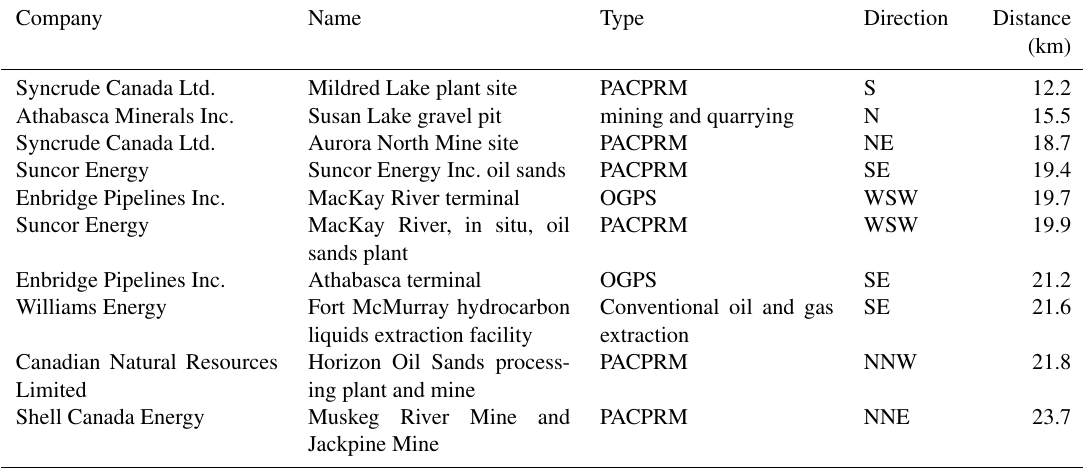
Table 1. Oil sands facilities located within 30km of AMS 13. Distances were estimated using coordinates provided in the National Pollutant Release Inventory (NPRI, 2013) and do not account for the size of each facility, whose boundaries may be considerably closer to (or further